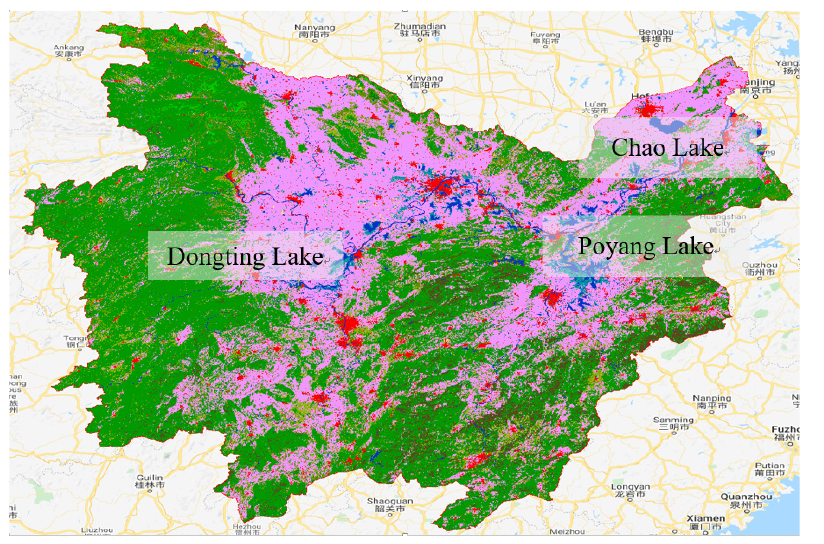
Figure 5. Study area with Copernicus Global Land Cover; pink for cropland, green for forest, blue for water, and red for built-up area.